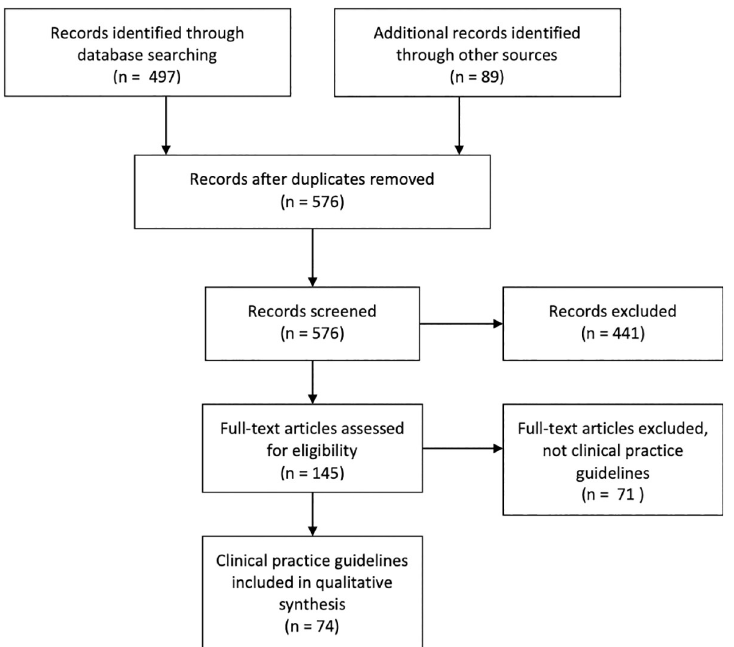
Fig 1. PRISMA flow diagram. Selection of guidelines.